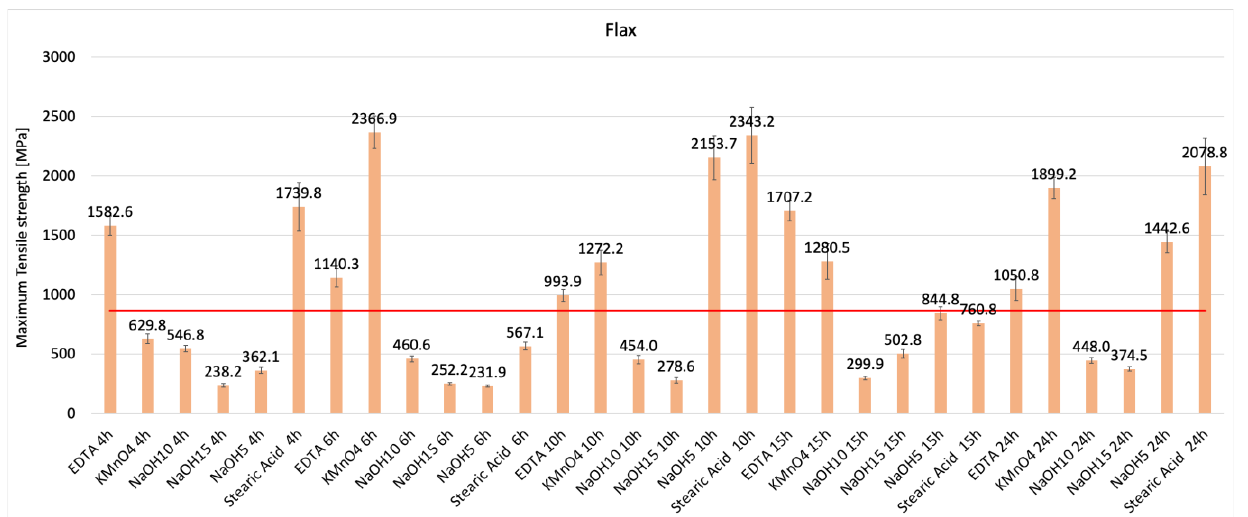
Figure 8. Maximum tensile strength obtained for each treatment on flax fibres.